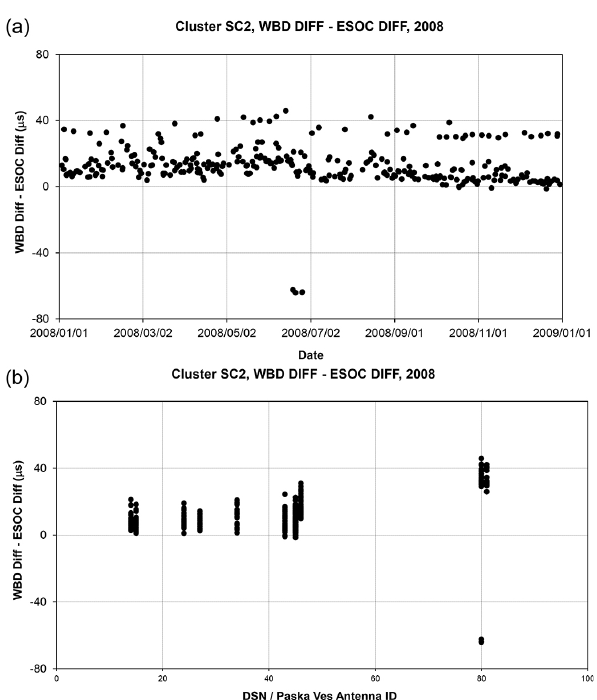
Fig. 3. Comparison of DIFF measured during WBD (DSN/Panska Ves) and ESOC ground station contacts. WBD-ESOC DIFF versus date shows a bias, usually small and positive (a) . Plotting the same data versus antenna ID shows antennae 46, 80 and 81 have a differ- ent bias to the others (b) . Data for antenna 80, near the end of June, are anomalous due to a timing problem at the Panska Ves